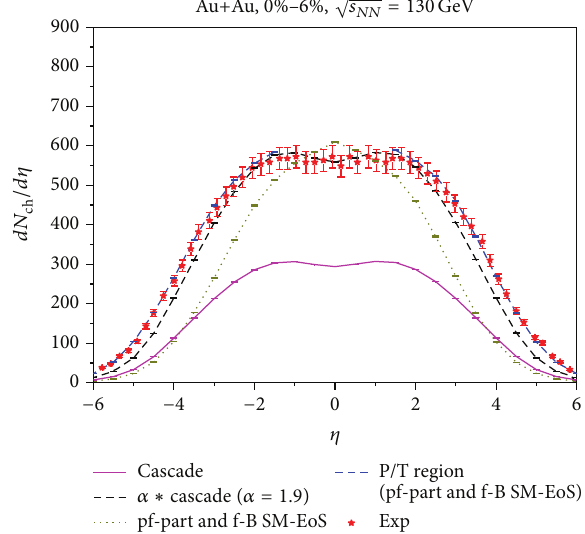
Figure 2: Charged particle pseudorapidity distributions for central Au+Aucollisionsat √𝑠 𝑁𝑁 = 130 GeV.Calculationswithcascadeand with potentials (“pf-part and f-B SM-EoS”) are shown by the curves. Experimental data taken from the PHOBOS collaboration [24] are represented by